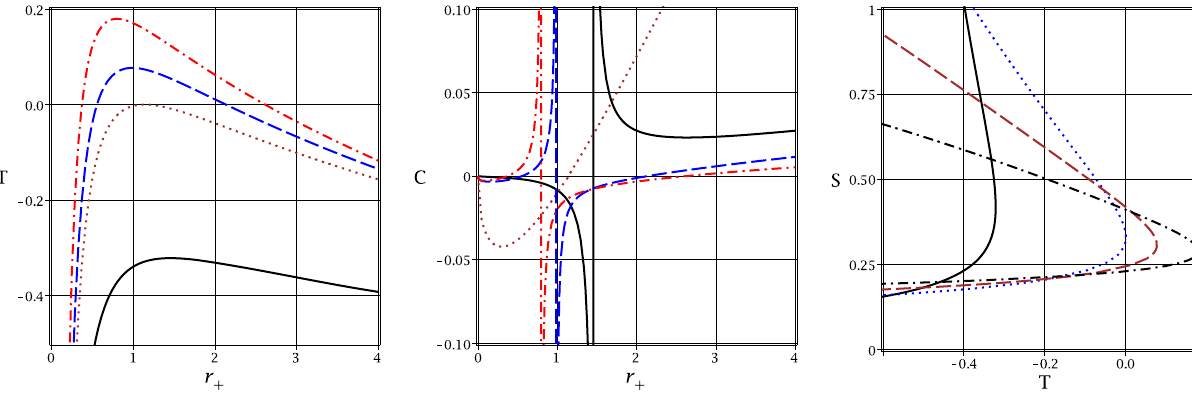
Fig. 3 For k = 1, m = 5, (cid:16) = − 1, b = 1, q = 1, β = 1, f (ε) = g (ε) = 0 . 9, α = 1 . 2 (continuous line), α = 1 . 6941 (dotted line), α = 2 (dashed line) and α = 2 . 4 (dashed-dotted line). T (left panel) and C (middle panel) versus r + ; S versus T (right